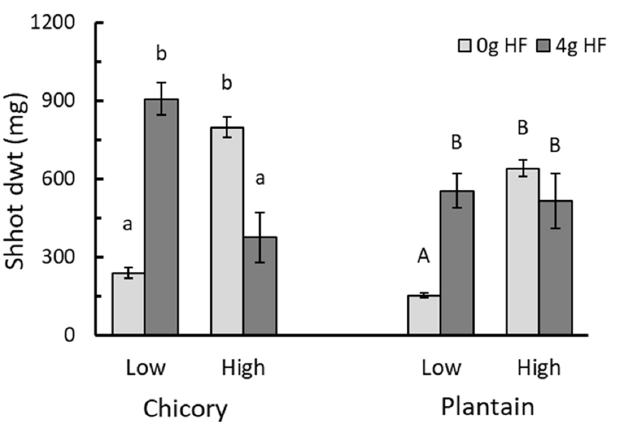
Figure 3. The influences of soil nutrients (Low vs. High) and HexaFrass™ (0 g vs. 4 g per pot) on the shoot dry weight (mg) of chicory and plantain grown under glasshouse conditions (mean ± SE). Only data for plants that survived until harvest are included. Letter codes separate treatments for each plant using LSDs at p < 0.05.